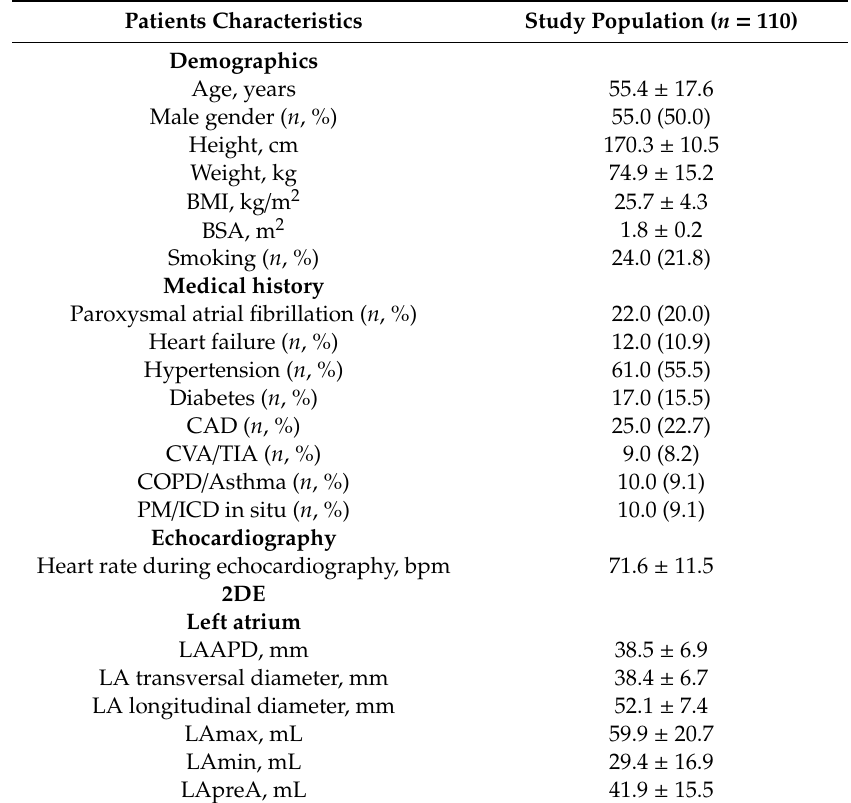
Table 1. Baseline clinical, demographic, and echocardiographic